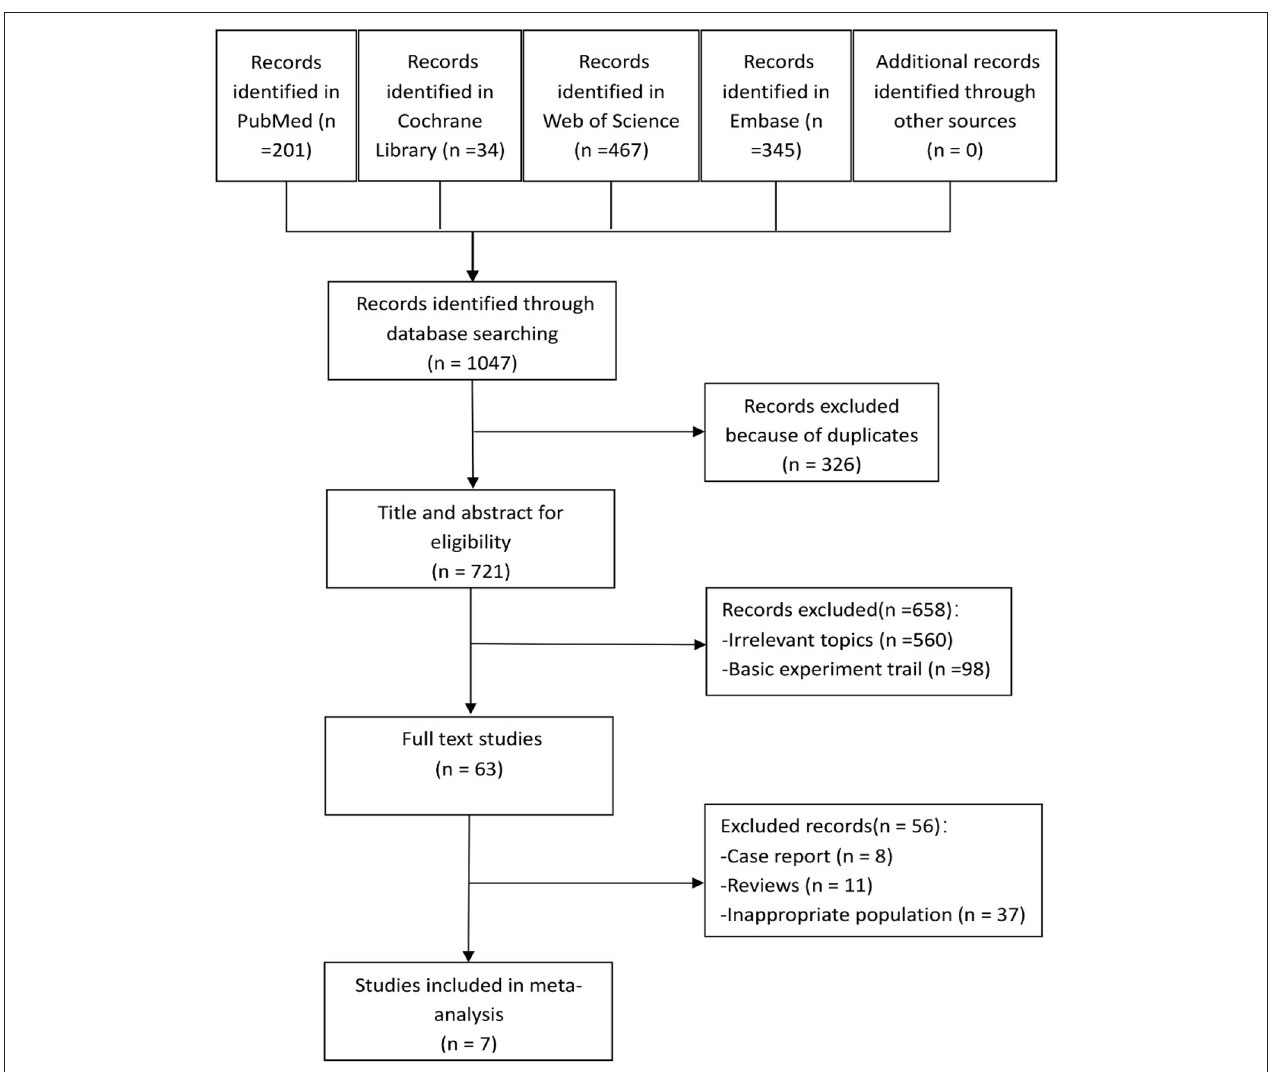
FIGURE 1 | Flowchart of the studies included.